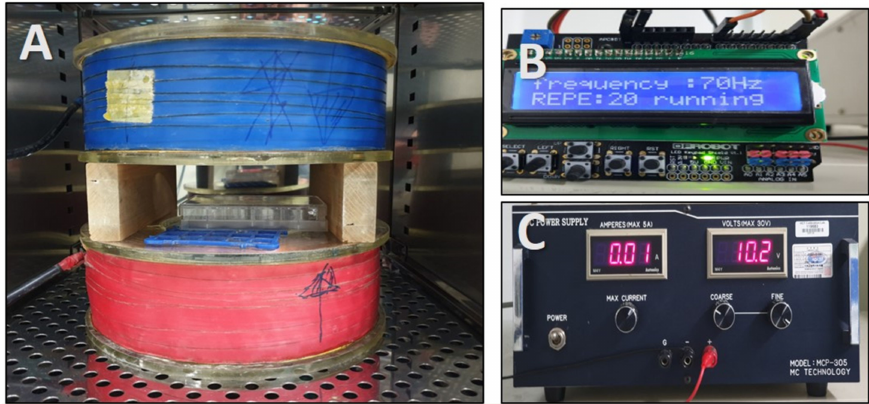
Figure 6. Photograph of the extremely low-frequency electromagnetic field (ELF-EMFEMF) device placed in an incubator. ELF-EMF was generated by using a pair of Helmholtz coils. ( A ) Helmholtz coil, ( B ) function generator, and ( C ) power